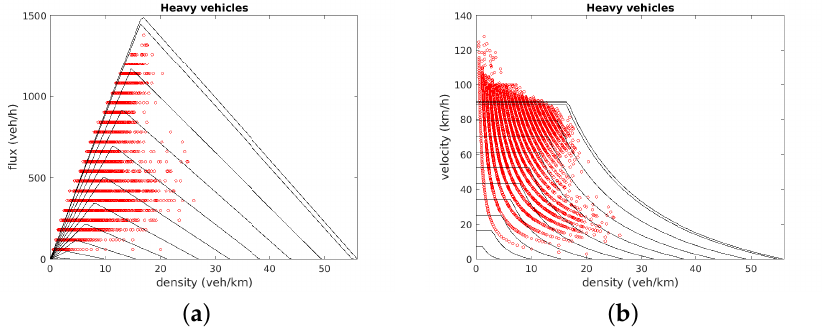
Figure 10. ( a ) Flux–density and ( b ) velocity–density relationships for trucks with real data superimposed.